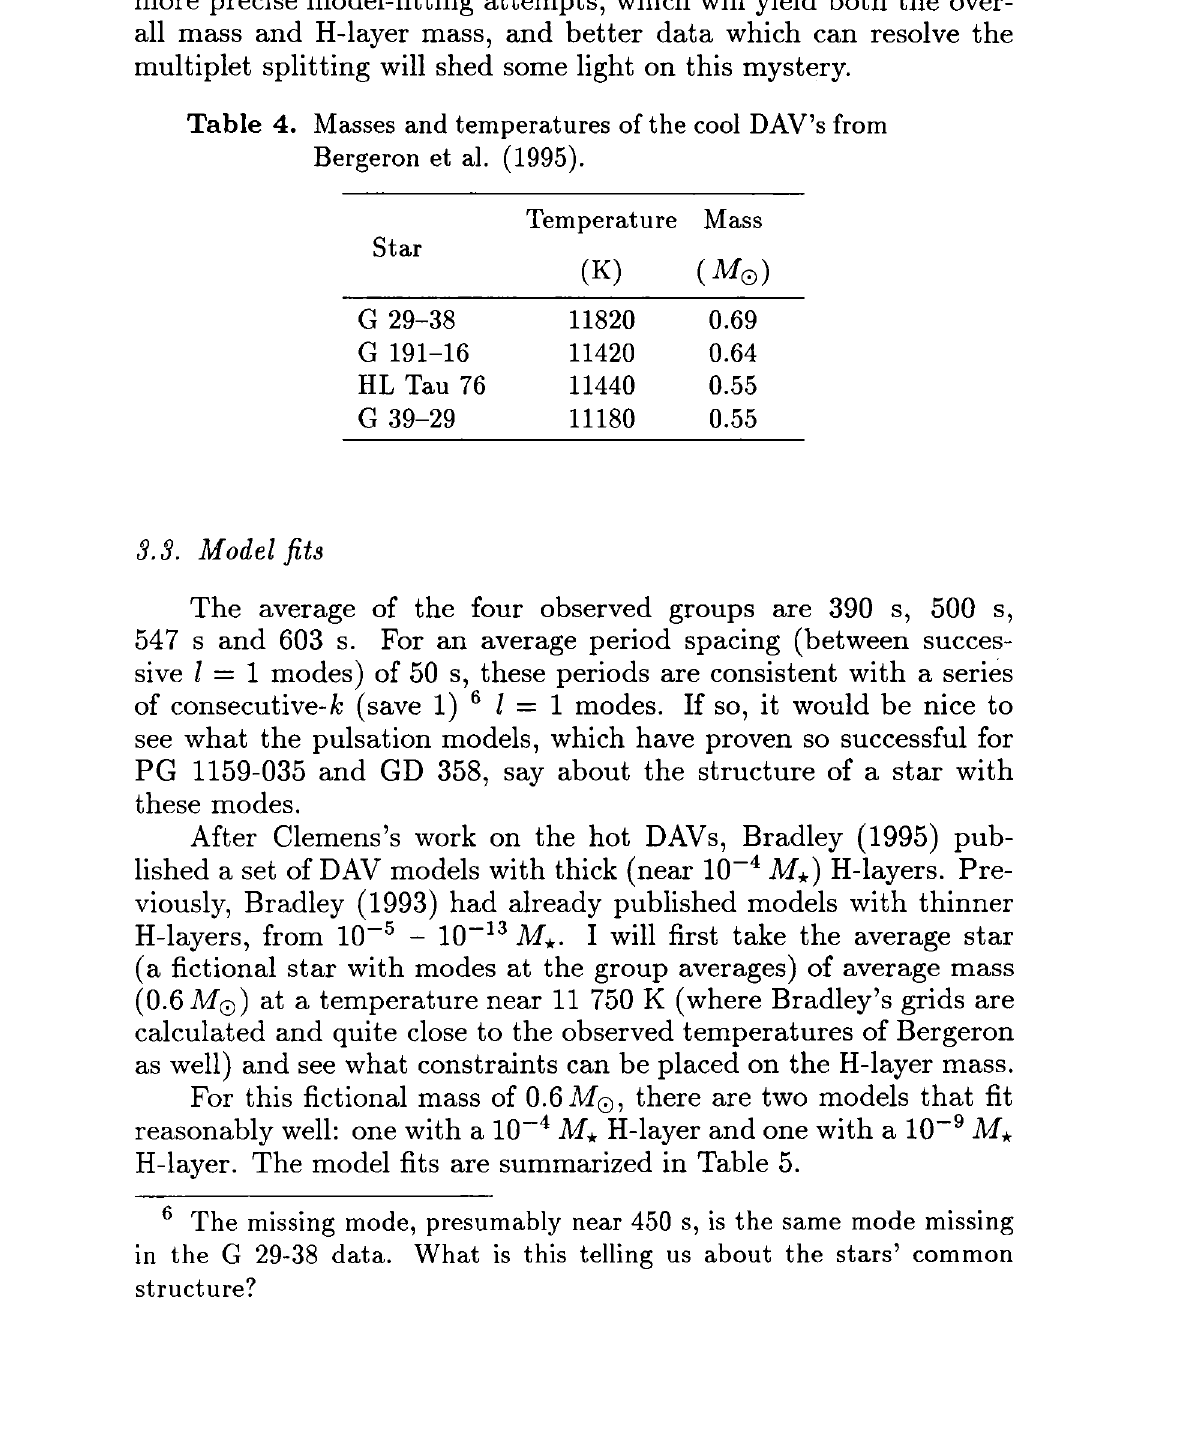
Table 4. Masses and temperatures of the cool DAV's from Bergeron et al.